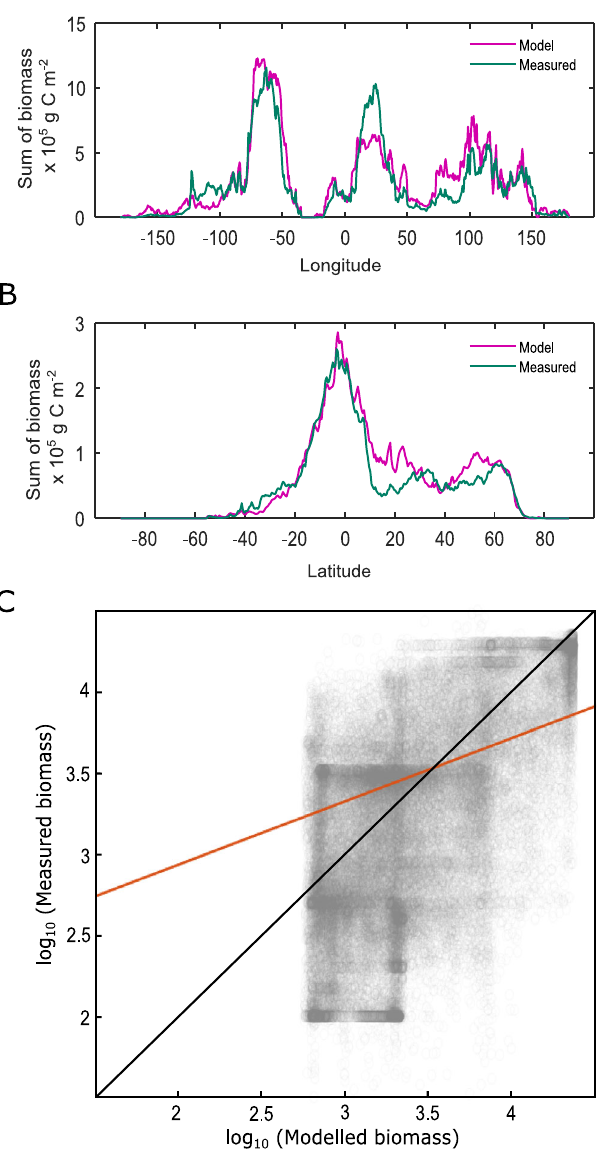
Fig. 4 | Further modelled and measured biomass comparison. A , B Sum of biomass between modelled (pink line) and measured (green line) data 35 show overalllongitude( − 180°Wto180°E)andlatitude( − 90°Sto90°N)biomasspatterns are preserved. Highest global plant biomass is present closer to the equator (0° Latitude). C Modelpredictedandmeasuredbiomassshowalinearrelationshipwith anR-squaredvalueof0.332inlogspace(orangeline),or0.496inlinearspace.A1:1 line is shown for comparison in